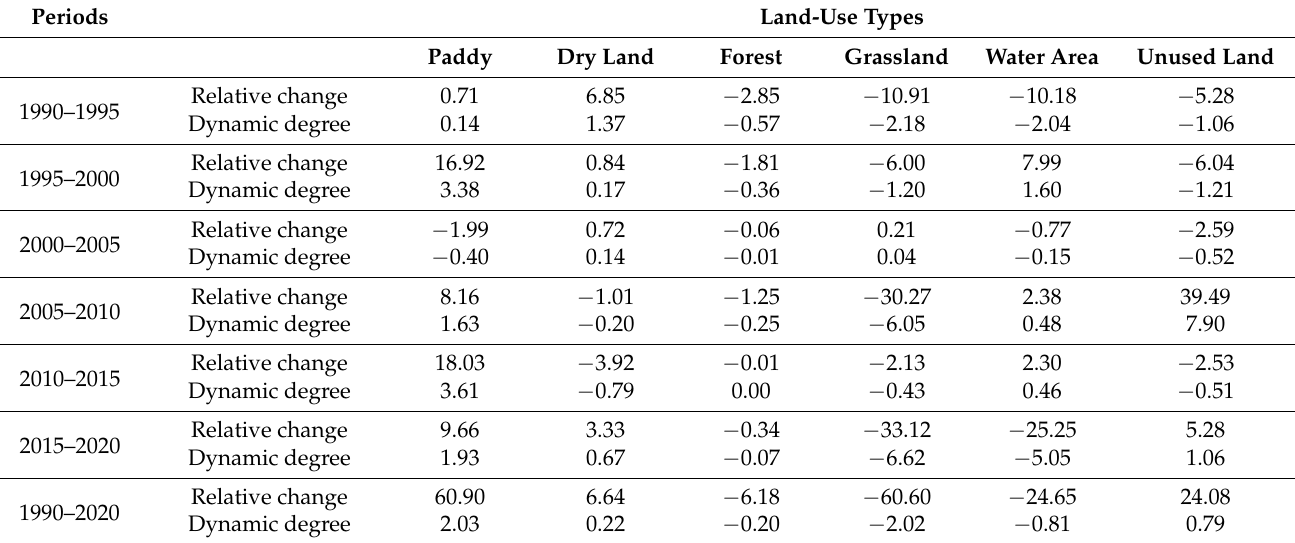
Table 2. Evolution of dynamic land-use types in the period of 1990–2020